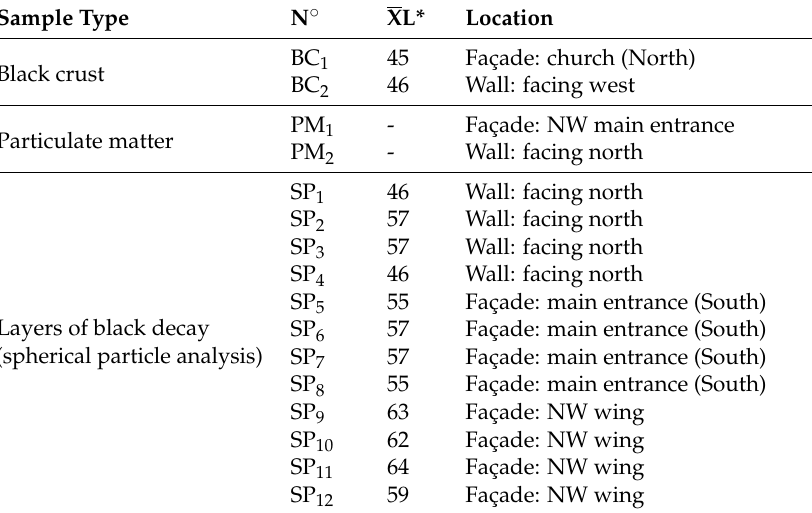
Table 1. Sample type and location and mean luminosity (XL*) measured on the surfaces sampled particulate matter; SP: samples taken to analyze air pollution-related